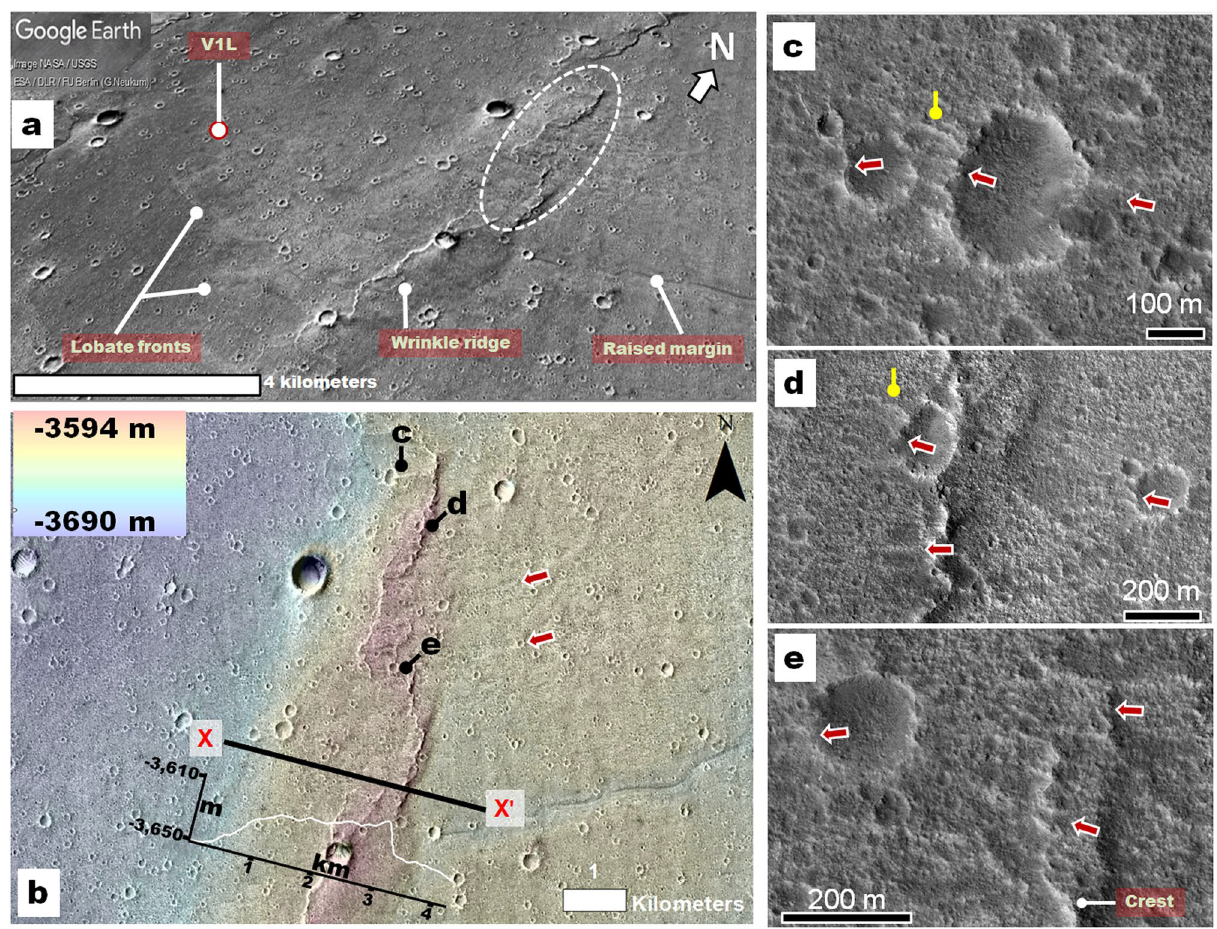
Figure 7. (a) CTX perspective view showing the V1L site (red-circled white dot) along the uppermost fringes of the remapped older megatsunami marginal deposit (V1LD, in Fig. 1b; Fig. 1a shows the deposit’s original mapping 6 ). Features diagnostic of run-up flow include (1) a scoured wrinkle ridge segment (dashed ellipse) separating (2) highland-facing lobate smooth areas and (3) a lower, scoured deposit section with raised margins. The image is rotated for better viewing (see north arrow orientation). This terrain assemblage is consistent with a megatsunami lobe propagating and decelerating over a wrinkle ridge, generating localized erosion on the ridge and lobate deposits beyond it. (b, north is up ) Close-up of the region within the dashed ellipse in panel (a) . The region includes west-trending lineations (red arrows) consistent with scouring by a unidirectional flow that started within the northern plains. The topographic profile X-X’ shows a relief measurement of the wrinkle ridge crest (~ 40 m), providing an approximation of the local overflowed topography. The image is a Digital Terrain Model (DTM) created from CTX images G02_018887_2026 and J04_046170_2025 (~ 24 m post spacing) using the Ames Stereo Pipeline superimposed on associated CTX orthorectified images (6 m per pixel, credit: NASA/ JPL/Malin Space Science Systems (https:// www. msss. com/ mro/ marci/ images/ tips/ media tips. html). (c–e, north is up) HiRISE ESP_072321_2025 (25 cm per pixel), close-up views at and near the proposed scoured section of the wrinkle ridge crest. The red arrows identify possible dissection marks, some which cut into the crest, as shown in panel (e) . The presence of craters with dissected rims (e.g., yellow pointers) indicates that the flow must have been extremely energetic and mostly erosional over the basement uplifted during wrinkle ridge formation. We produced this figure using Esri’s ArcGIS 10.3 (http:// www. esri. com/ softw are/